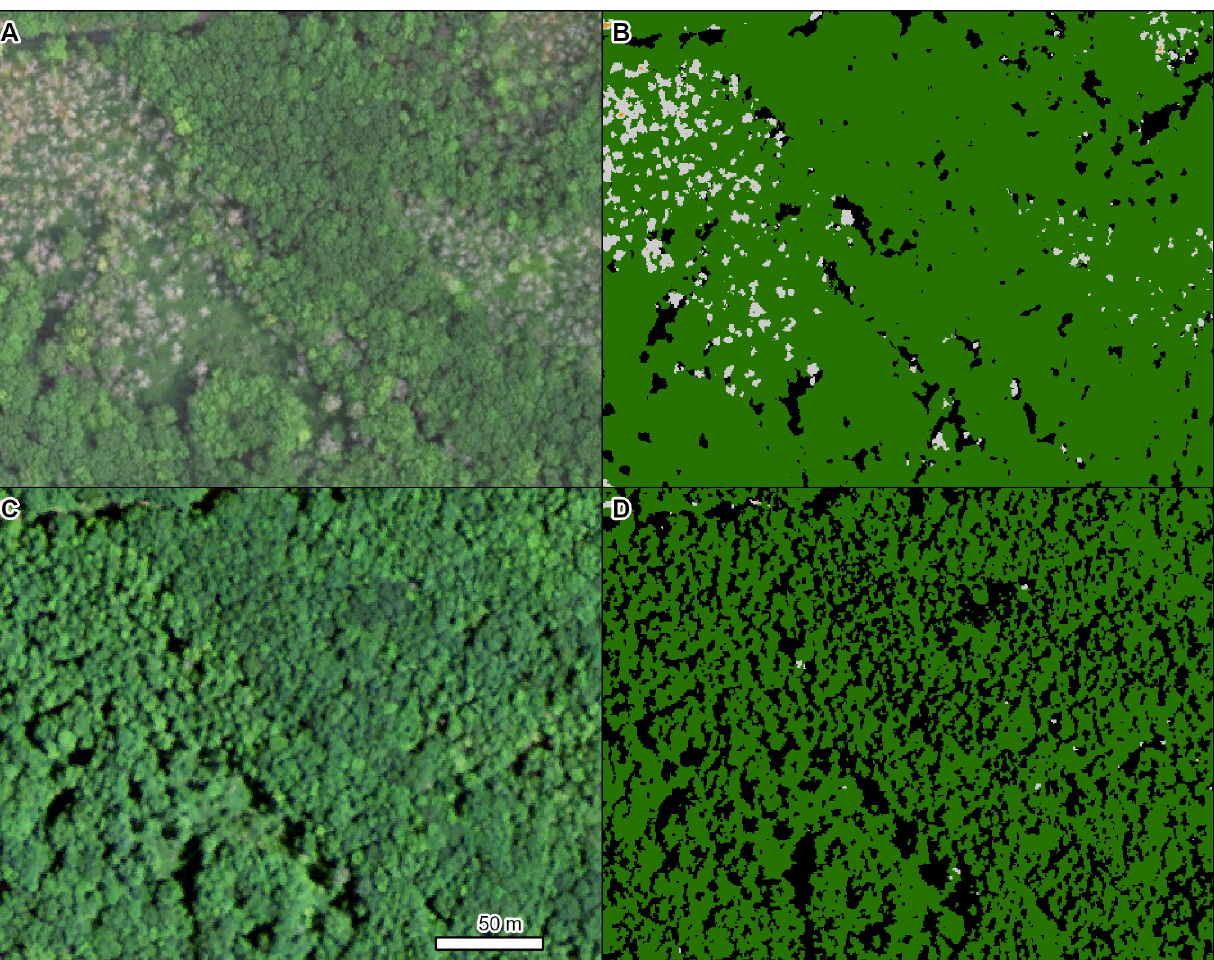
Fig 4. Mortality in a mixed stand of white ash ( Fraxinus americana L.), green ash ( F . pennsylvanica Marsh), and black ash ( F . nigra Marsh) caused by emerald ash borer ( Agrilus planipennis ). Left panels are NAIP imagery from 2016 (A) and 2012 (C). Right panels (B, D) are the corresponding TCH model results from each year (light gray = gray crowns, dark green = green crowns, black = shadowed crowns). Note: None of the red crown color class existed in this area. Location: Eastern Michigan, near Lake Huron. Insect and Disease Survey database DAMAGE_AREA_ID: {7a2df48e-6e22-45bd-b9cf- b0e8d5a28536}. NAIP imagery (public domain) provided by USDA-FSA-APFO.